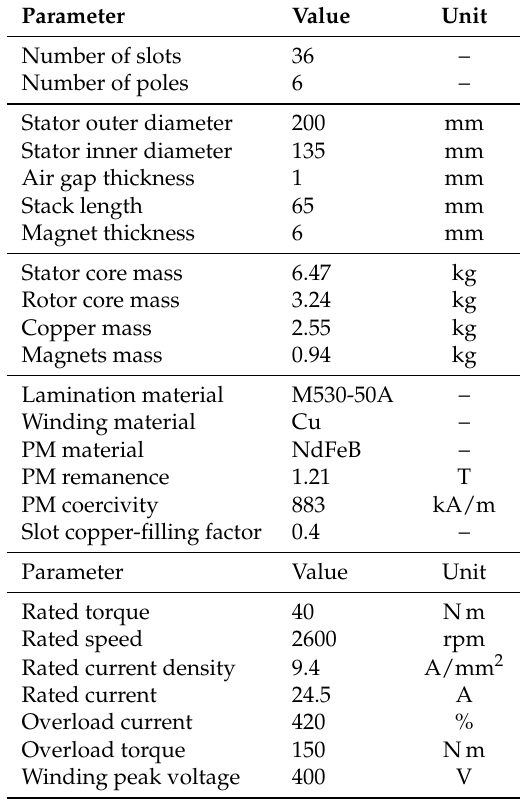
Table 2. Electric motor geometrical data and